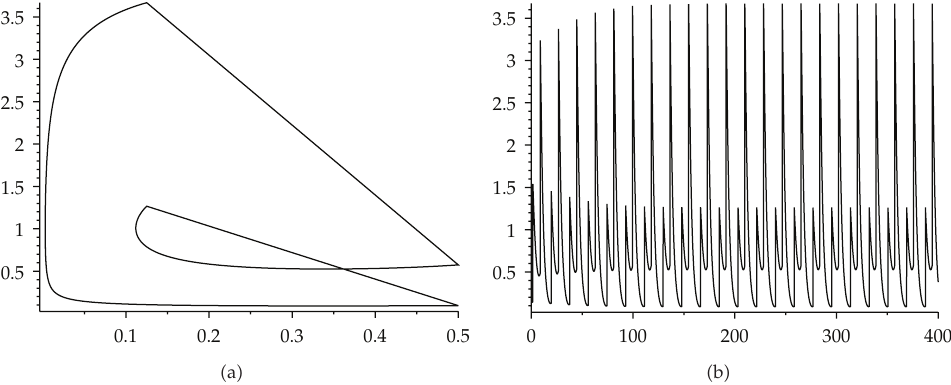
Figure 7: Periodic solution of system (cid:9) 1.3 (cid:10) with p (cid:6) 0 . 75, h (cid:6) 0 . 5, τ (cid:6) 0 . 8. (cid:9) a (cid:10) Phase diagram, (cid:9) b (cid:10) time series of y